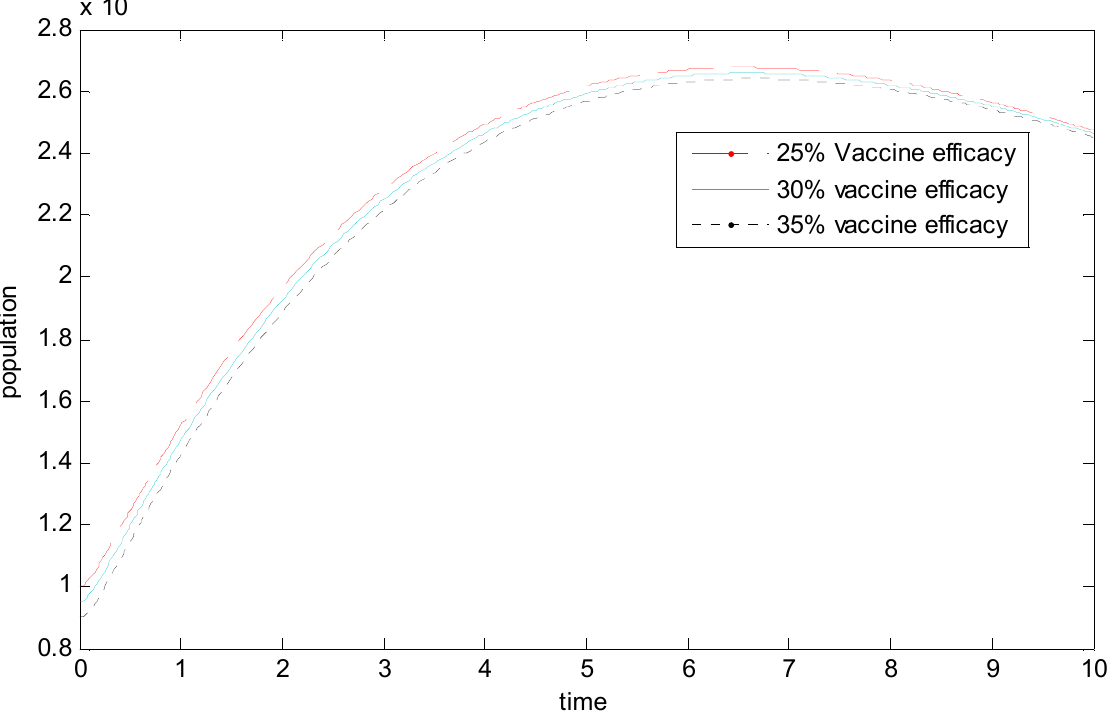
Figure 6. Comparing the vaccine efficacy in the infected population.